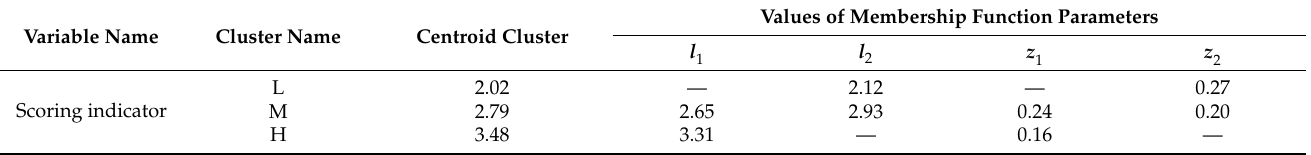
Table 4. Cluster parameters and parameters of scoring index membership functions based on the results of neural processing.